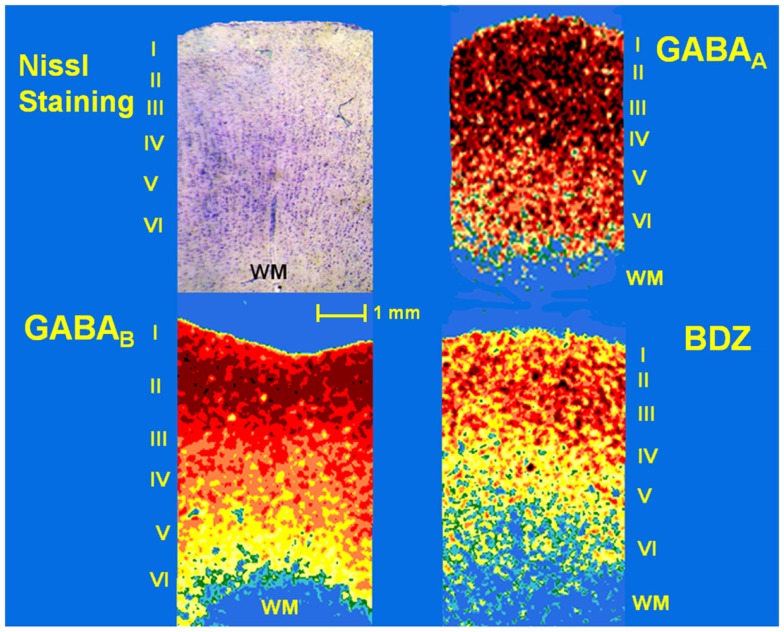
Photomicrograph of a Nissl-stained section (showing layers I–VI) and pseudo-color autoradiographs obtained from an autopsy sample. Autoradiographs show the distribution of binding to GABAA and GABAB receptors as well as benzodiazepine (BDZ) sites, labeled with [3H]-Muscimol, [3H]-CGP54626, and [3H]-Flunitrazepam, respectively. High binding appears as red and orange areas, low binding is indicated as yellow and green areas, whereas blue areas represent absence of binding.